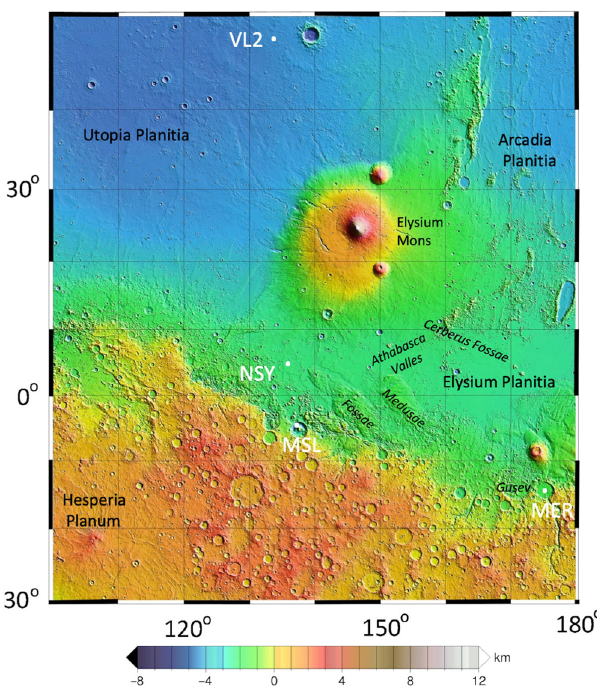
Fig. 1 Topographic map of the region around the InSight landing site. The map shows InSight (NSY) and major physiographic features as well as the landing sites of the Viking Lander 2 (VL2), Mars Science Laboratory (MSL) Curiosity in Gale crater, and the Mars Exploration Rover (MER) Spirit in Gusev crater. InSight landed near the dichotomy boundary between the heavily cratered highlands to the south and the northern lowlands. Volcanic fl ows from Elysium Mons fl owed to the south and very young lavas from Cerberus Fossae fl owed down Athabasca Valles to 150 km to the east of the lander. The map is a portion of the MOLA shaded relief topographic map of Mars with elevations with respect to the geoid.